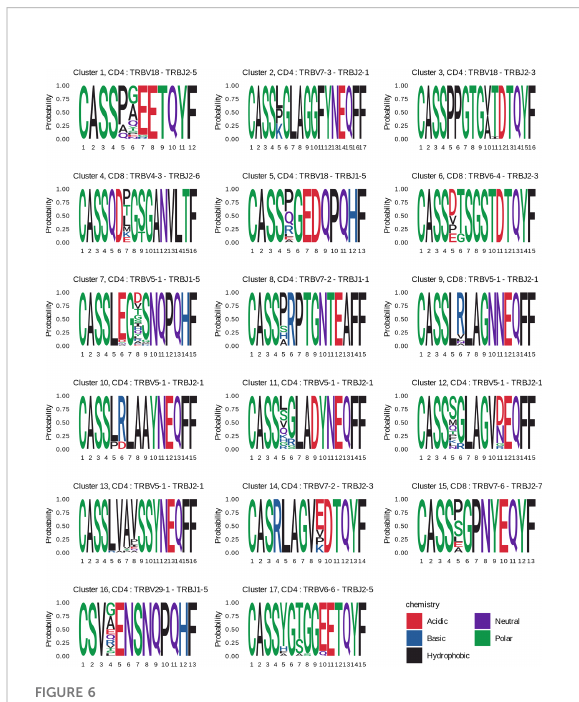
FIGURE 6 CDR3 amino acids motifs of clustered clonotypes from different donors. CDR3 amino acid sequences of the responded clonotypes from the indicated clusters are presented as sequence logos. Cluster numbers (as in Figure 5), phenotypes (CD4 + or CD8 + ), and V-J segments of T cell clones are shown on the top of the logos. Amino acids are colored according to their chemical